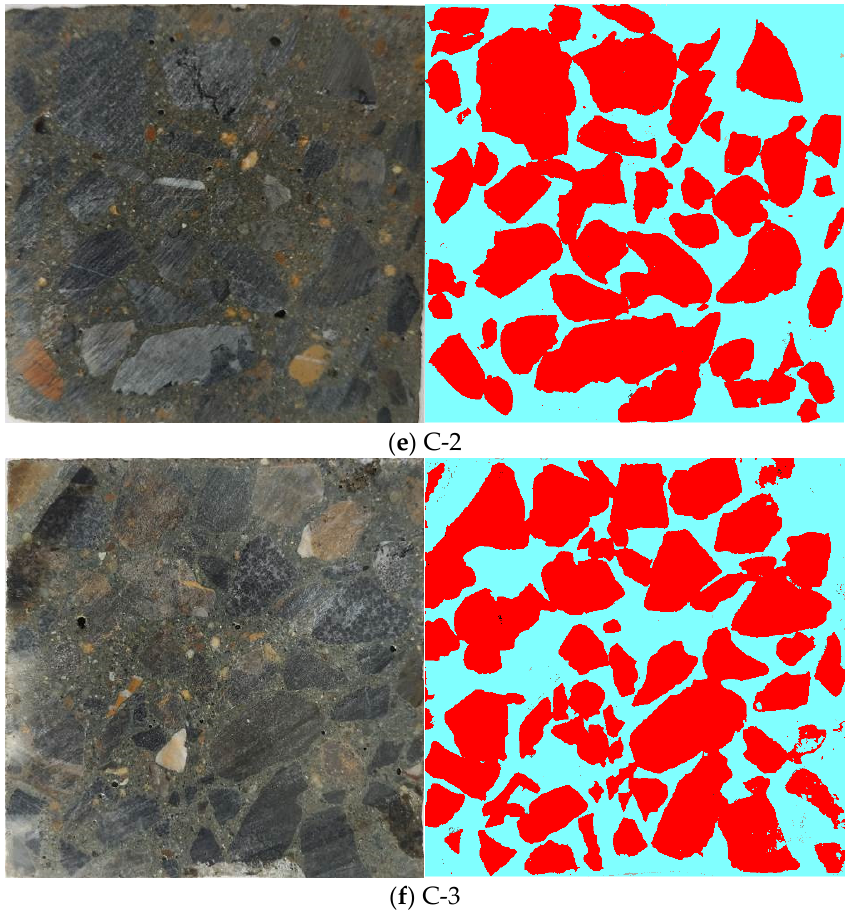
Figure 5. Distribution of coarse aggregate in sections of concrete.